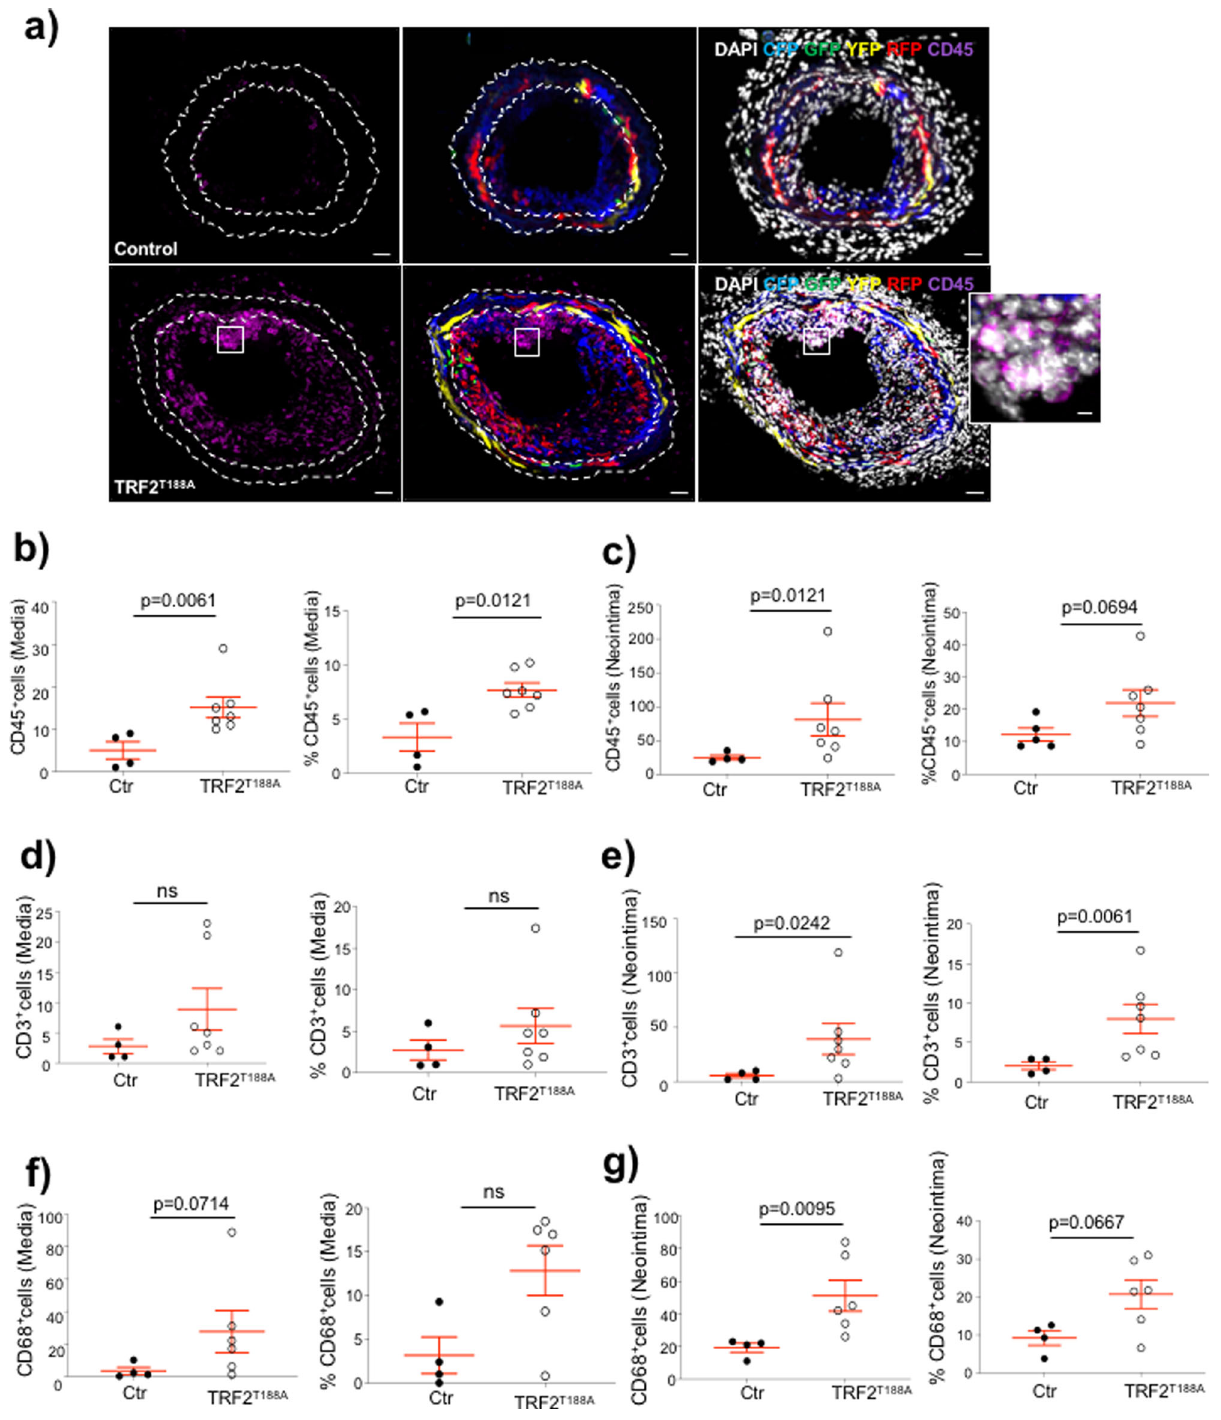
stained with CD45 (magenta) and counterstained with DAPI (white). Outlined region shows magni fi ed cluster of cells that are CD45 + . Scale bar = 30 μ m and 5.6 μ m (inset). Total numbers and % of CD45 + cells in b media and c neointima, total numbers, and % of CD3 + cells in d media and e neointima or total numbers and % of CD68 + cells in f media and g neointima. Data represent means ± SEM, n ≥ 4 mice per group, unpaired, two-tailed Student ’ s t test or Mann – Whitney U